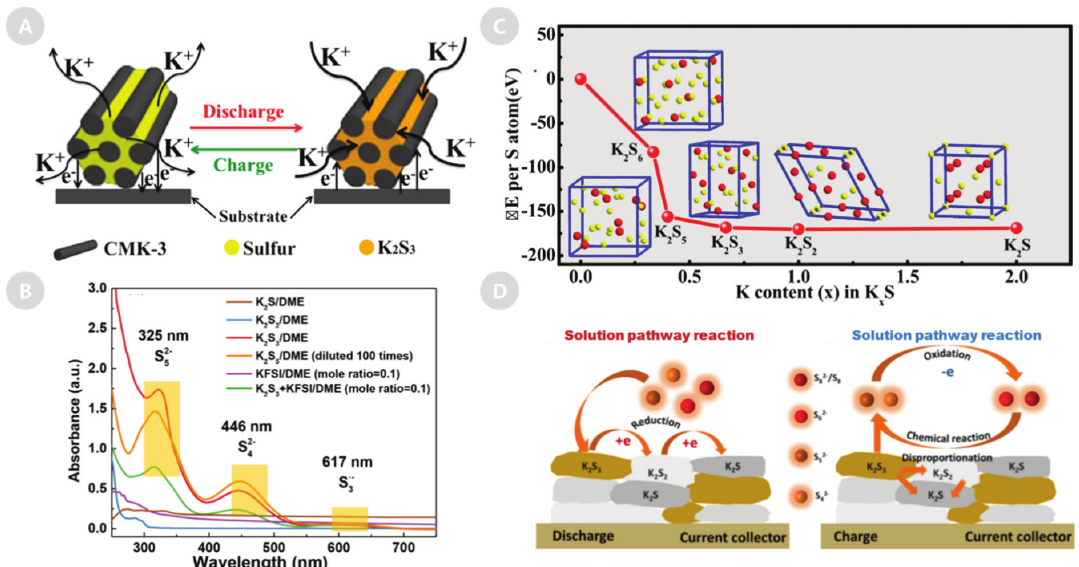
Figure 2. ( A ) Schematic of electrode reactions of rechargeable K–S batteries with CMK-3/S cathode. Figure adapted from Reference [6]. ( B ) Ultraviolet-visible (UV-vis) spectra of soluble phases of K 2 S, K 2 S 2 , K 2 S 3 , and K 2 S 5 in 1,2-dimethoxyethane (DME) and Potassium bis(fluorosulfonyl)imide(KFSI)-DME electrolytes. Figure adapted from Reference [15]. ( C ) Formation energies of potassium sulfides calculated via theoretical calculations. Figure adapted from Reference [16]. ( D ) The reaction mechanism for K–S batteries during cycling (left-side), the solid conversion reaction during discharging (middle) and the solution pathway reaction during charging (right-side). Figure adapted from Reference [15].